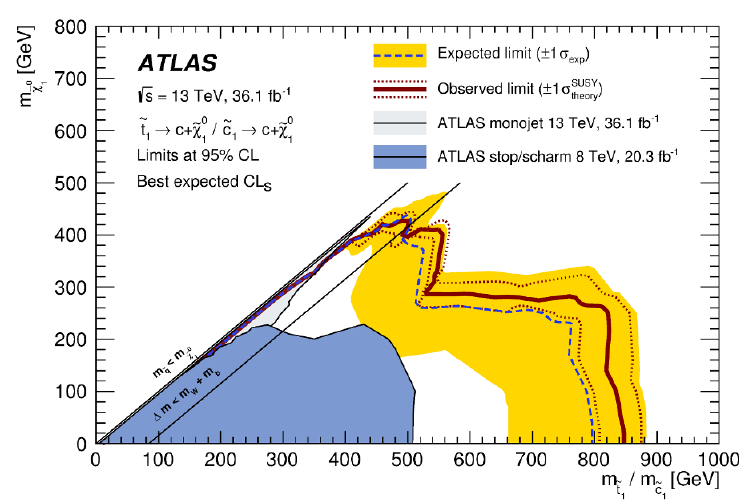
Figure 6 . Observed and expected exclusion contours at 95% CL, as well as (cid:6) 1 (cid:27) variation of the expected limit, in the ~ t 1 ; ~ c 1 -~ (cid:31) 0 1 mass plane. The SR with the best expected sensitivity is adopted for each point of the parameter space. The solid band around the expected limit (dashed line) shows the impact of the experimental and SM background theoretical uncertainties. The dotted lines show the impact on the observed limit of the variation of the nominal signal cross-section by (cid:6) 1 (cid:27) p of its theoretical uncertainties. The observed limit from the monojet search at s = 13 TeV [64] p and from the Run-1 analysis [20, 21] at s = 8 TeV are also overlaid. (cid:1) m denotes m ~ (cid:0) m : t 1 ; ~ c 1 ~ (cid:31) 0 1